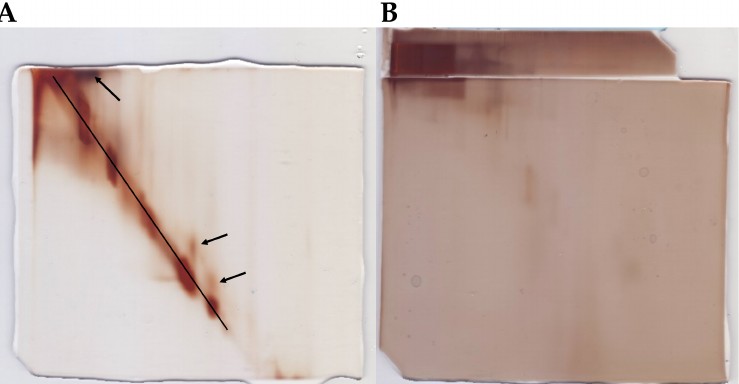
Figure 7. Results of in-house 2D PAGE for detecting intrinsically disordered proteins. ( A ) Proteins from heat-treated samples have successfully entered the second dimension. The black line represents the diagonal along which IDPs are located. Arrows denote ordered proteins that stay above the diagonal. ( B ) Proteins from non-heated samples are mostly locked in the gel from the first dimension (strip overlaying the larger gel).